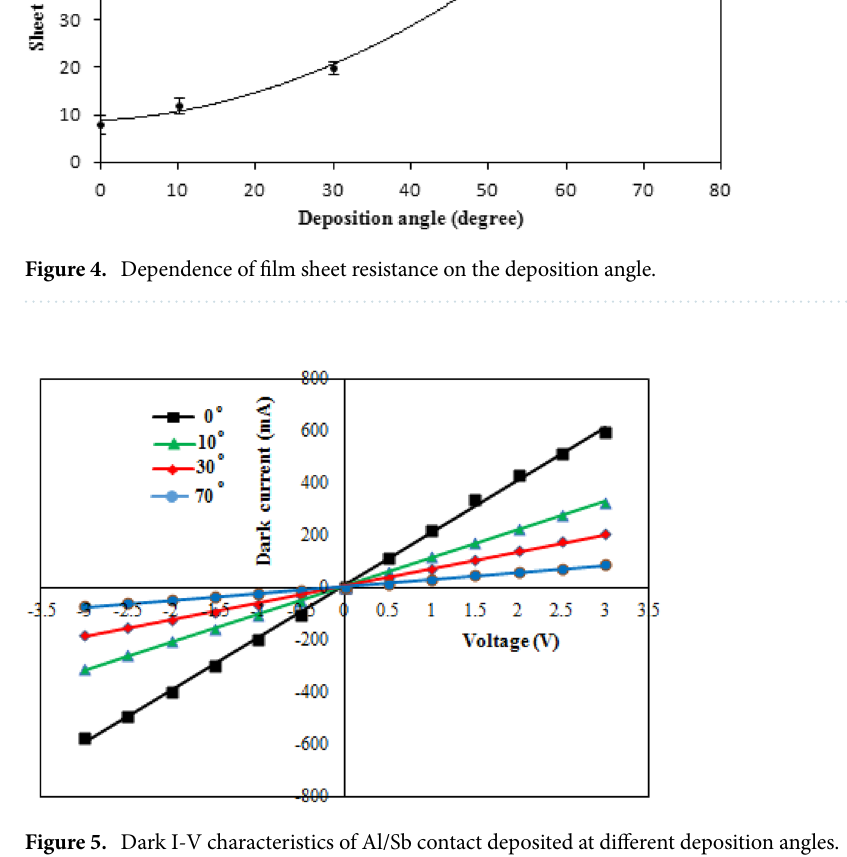
Figure 5. Dark I-V characteristics of Al/Sb contact deposited at different deposition angles.